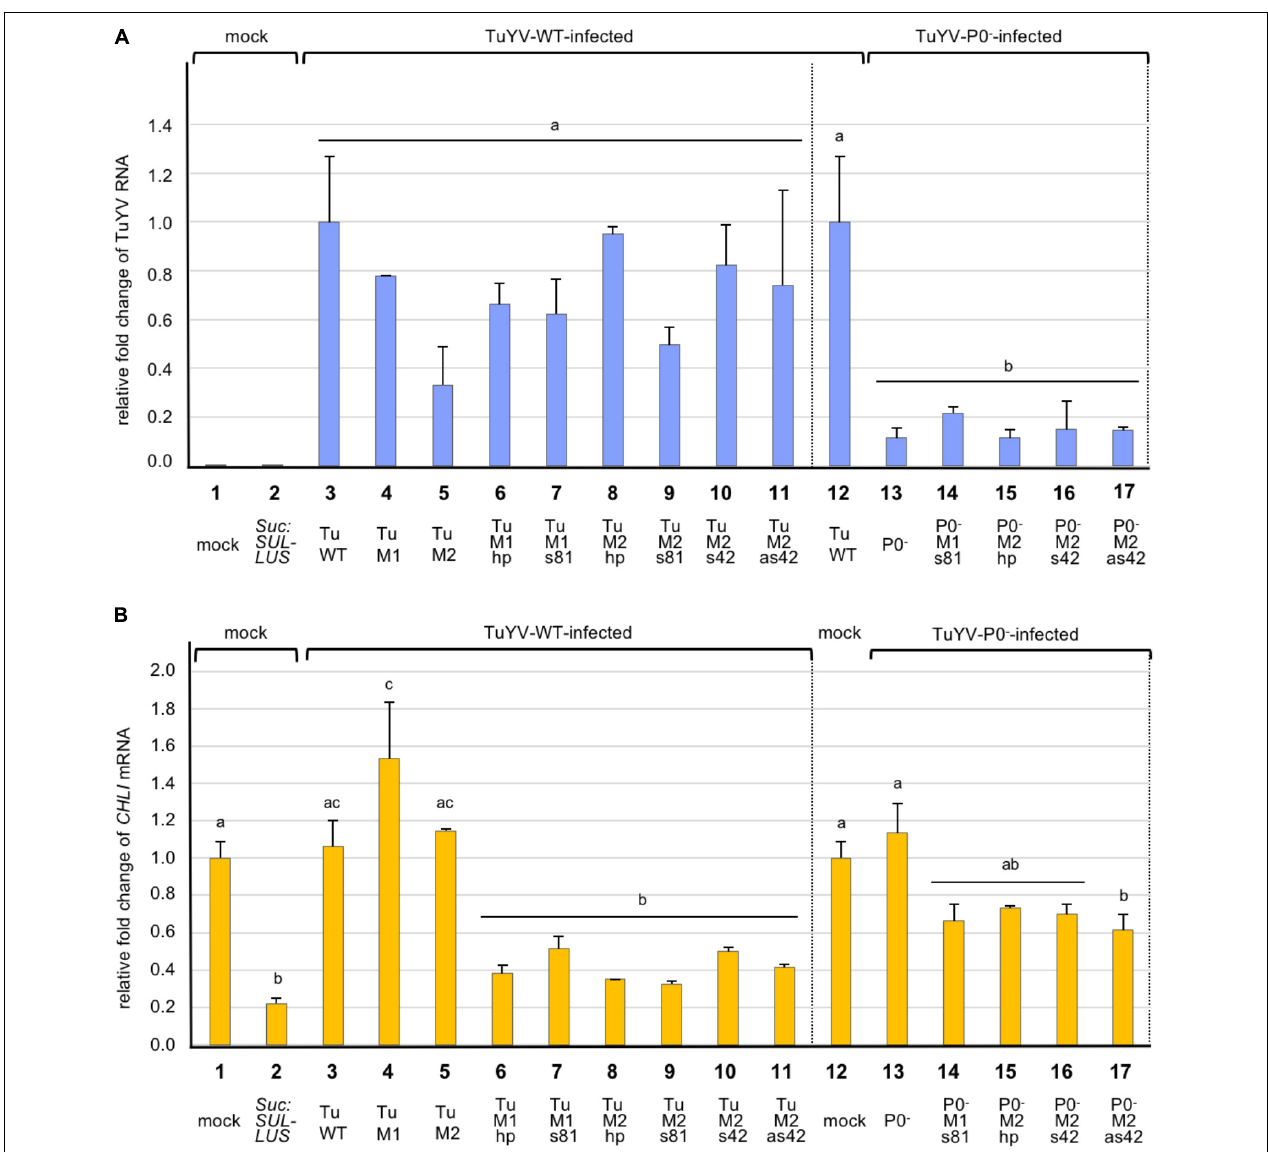
FIGURE 4 | Analysis by real-time RT-PCR of the accumulation of TuYV RNA (A) , and CHLI1 transcripts (B) , in plants infected with different TuYV recombinant viruses in A. thaliana Col-0 ecotype 19 dpi. The bars represent the fold-change of viral RNA or cellular CHLI1 transcripts in upper non-inoculated leaves of infected plants, with the TuWT RNA value in infected plants (column 3 and 12, panel A) and CHLI1 transcript value from mock-inoculated plants (column 1 and 12, panel B) arbitrarily set as references. Suc:SUL-LUS corresponds to non-inoculated transgenic plants expressing a hairpin directed against the CHLI1 gene under the control of the Suc2 promoter (column 2). TuWT and derived variants (M1, M2, M1hp, M1s81, M2hp, M2s81, M2s42, and M2as42) correspond to plants infected with the relevant viruses (columns 3–11). P0 - , P0 - M1s81, P0 - M2hp, P0 - M2s42, and P0 - M2as42 are the mutant viruses in the P0 - background (columns 13–17). Data are the mean value ± SE from two to five pools of two plants each (total of 4–10 plants/condition). Statistical analyses were performed using one-way ANOVA following by Tukey’s post-hoc test. Different letters above the bars indicate statistically significant differences in the quantification of TuYV RNA (A) and CHLI1 transcripts (B) ( p -value < 0.05), while the same letters indicate no statistically significant differences. The data originate from a single experiment but to make the figure easier to interpret visually, both panels were split with a dotted vertical line and the reference values placed in two locations in each panel, next to the WT-derivative virus values and next to the P0-derivative virus values (panel A, columns 3 and 12; panel B, columns 1 and